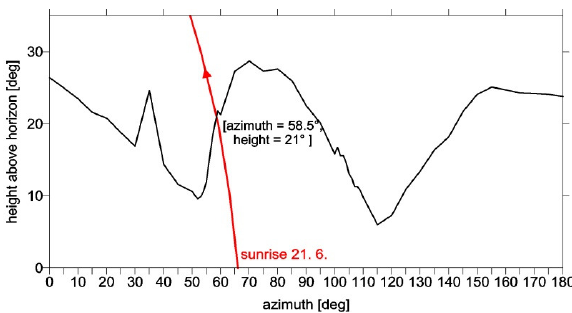
Figure 3: Altitude profile was created from DTM in direction from north to east. Observing point is Temple of the Sun. The red line shows sunrise at the winter solstice.